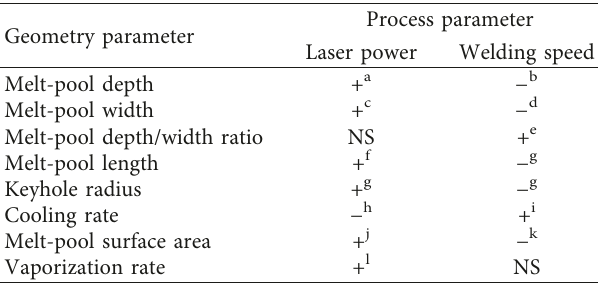
Table 1: Influence of two laser welding parameters on various melt-pool geometry